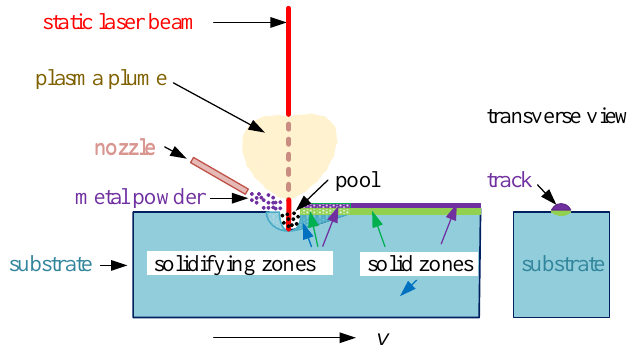
Figure 1. Basic scheme of the process.